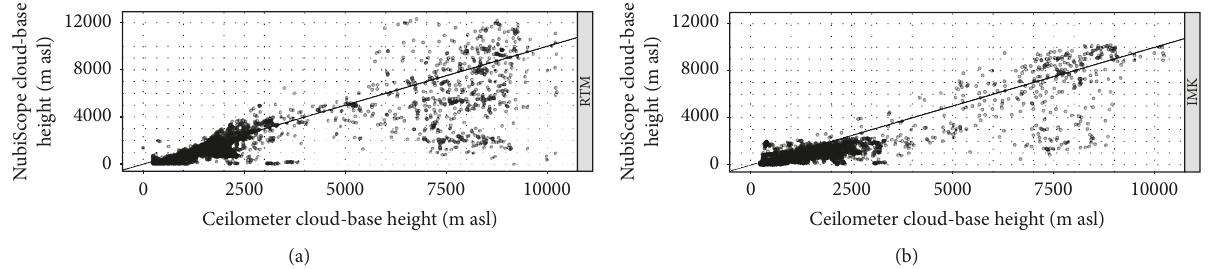
Figure 8: Comparison of cloud-base height derived by ceilometer and NubiScope. Two panels refer to CBH derived with algorithm presented in this study (RTM, (a)) and manufacturer’s algorithm (IMK, (b)). Solid diagonal lines represent 1:1 lines.